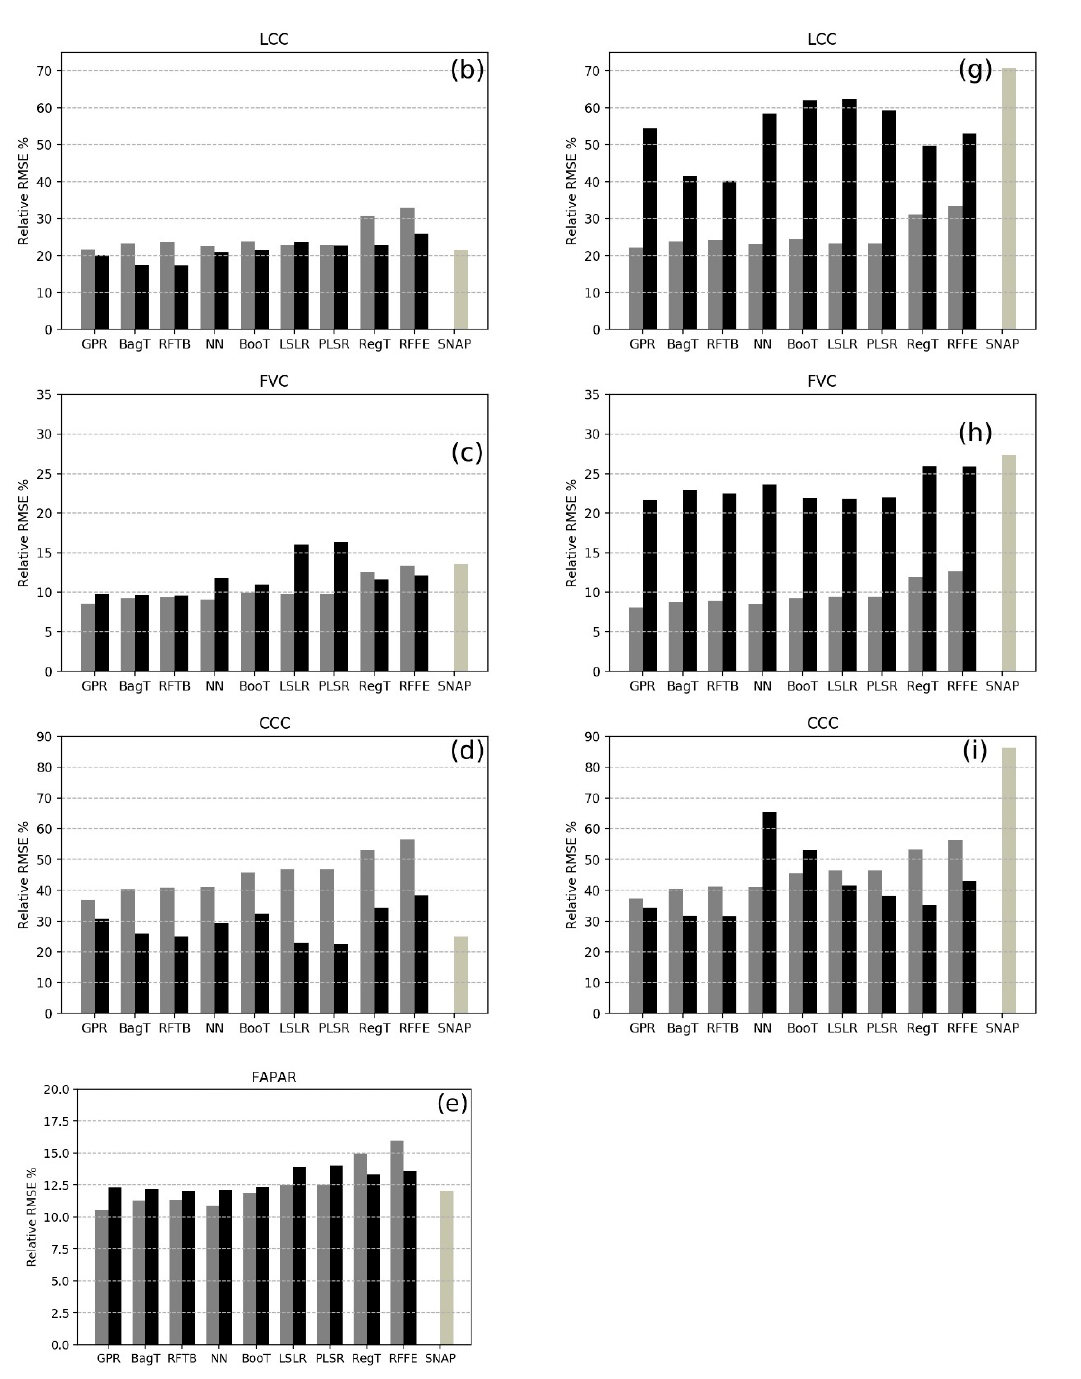
Figure 5. RRMSE (%) for LAI, LCC, FVC, CCC, and FAPAR for Maccarese, Italy (left) and LAI, LCC, FVC, and CCC for Shunyi, China (right).